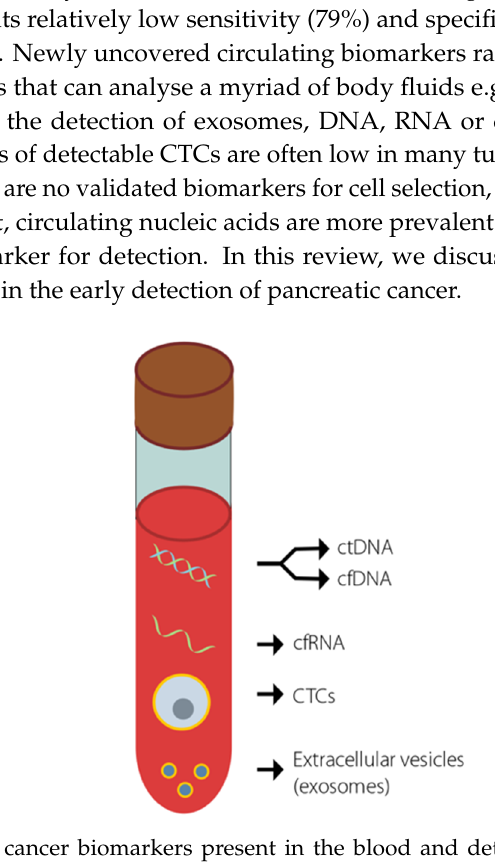
Figure 1. Potential cancer biomarkers present in the blood and detectable using liquid biopsies. Key biomarkers that are currently used in an attempt to detect early stage cancer are shown.